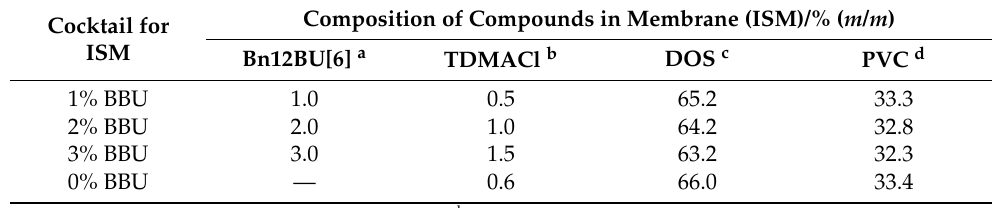
Table 1. Cocktail compositions for ISM preparation (compounds were dissolved in 1.0 mL THF solution, the molar ratio TDMACl/Bn12BU[6] ~1.75).